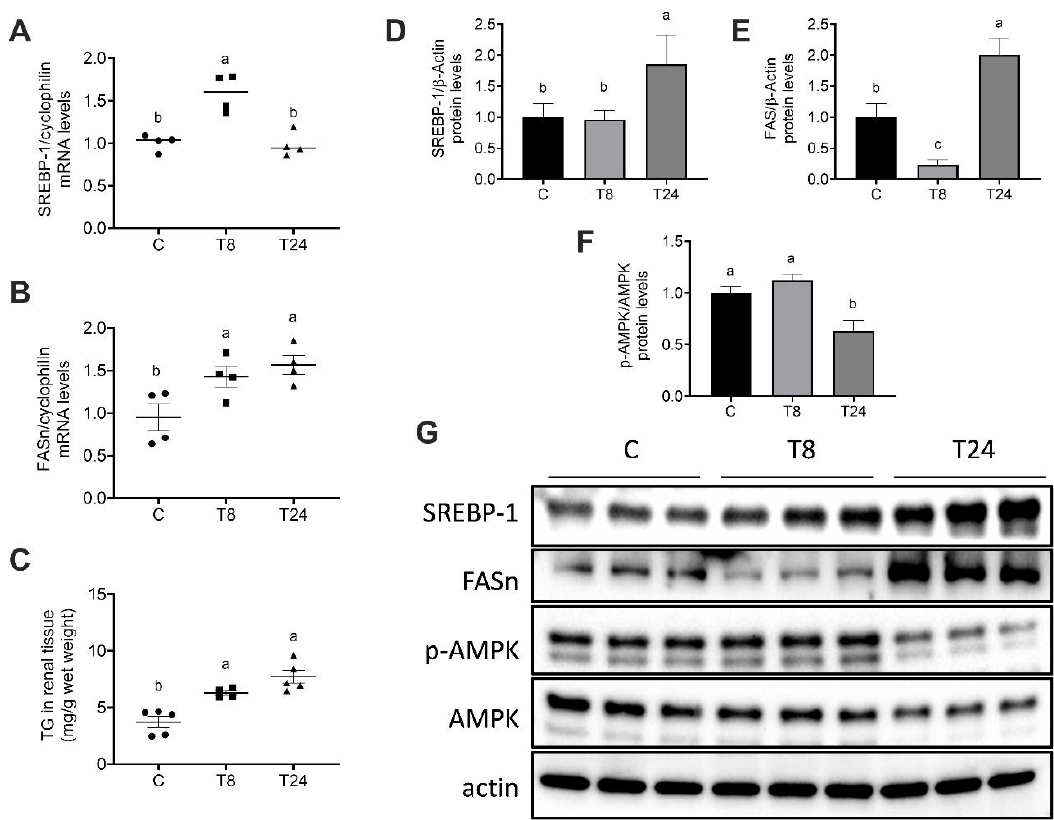
Figure 5. ER stress-induced renal lipogenesis in mice treated with tunicamycin. Mice were treated with a single i.p. injection of vehicle or tunicamycin (1 g/Kg body weight), and kidneys were obtained after 8 h (T8) or 24 h (T24). mRNA content of SREBP-1 ( A ) and FASn ( B ), triglyceride content in renal tissue ( C ), densitometric analysis of the protein content of SREBP-1 ( D ), FASn ( E ) and p-AMPK/AMPK ( F ), protein content of SREBP-1, FASn, AMPK and p-AMPK (thr 172) ( G ). Values are means ± SEM, n = 4–6. Means without a common letter differ significantly, a > b > c ( p < 0.05).